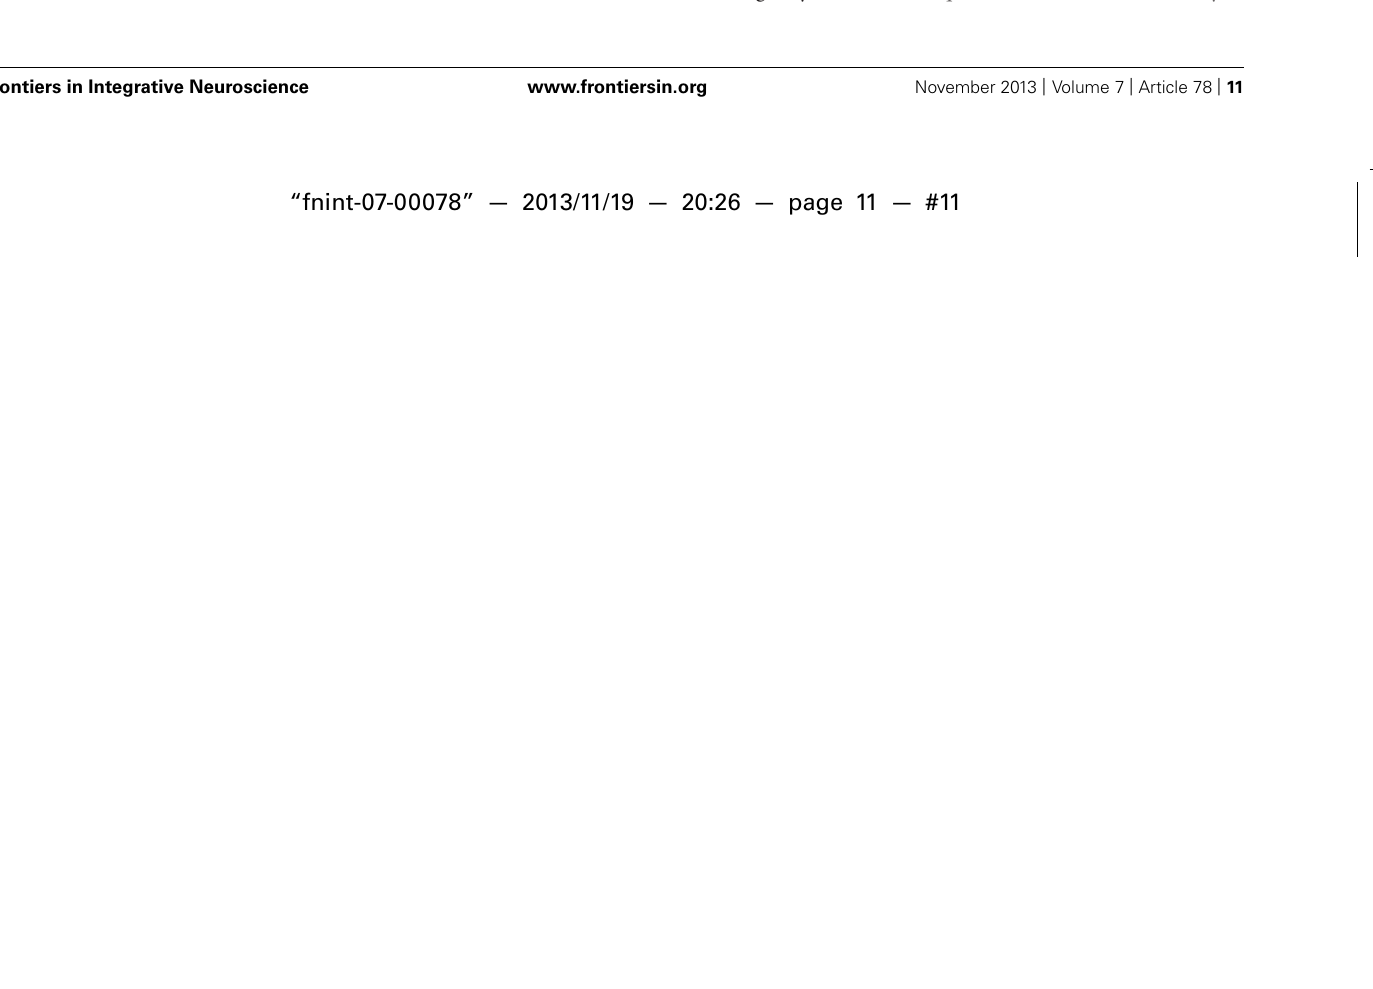
FIGURE 6 | Estimated group identities based on cognitive modeling results. Both plots show each subject’s likelihood to choose the aggressive action (escalate) for the two different conditions. Red and green dots correspond to subjects that showed a respective increased or decreased probability to escalate from their baselines. Error bars show the 95% Bayesian confidence interval of the posterior mean.The x -axes indicate subject numbers, which correspond to the same subjects in the two plots. The y -axes show the Bayesian model’s mean output indicating group affiliation with respect to the subject’s likelihood to escalate, relative to their independently determined baselines.The y -axis value of 1 indicates a strong likelihood of decreasing choices to escalate relative to their baseline level for the conditions, whereas the value of 2 indicates a strong likelihood of increasing choices to escalate relative to their baseline level for the conditions.The group identities were estimated based on: (A) the influence tryptophan depletion had on subjects’ choices for aggressive actions (Escalation,Tryptophan), and (B) the influence an embodied agent had on subjects’ choices for aggressive actions (Escalation, Robot). Cognitive Science Conference and published in the Proceedings (COGSCI 2012, Sapporo, JP) from Asher etal.